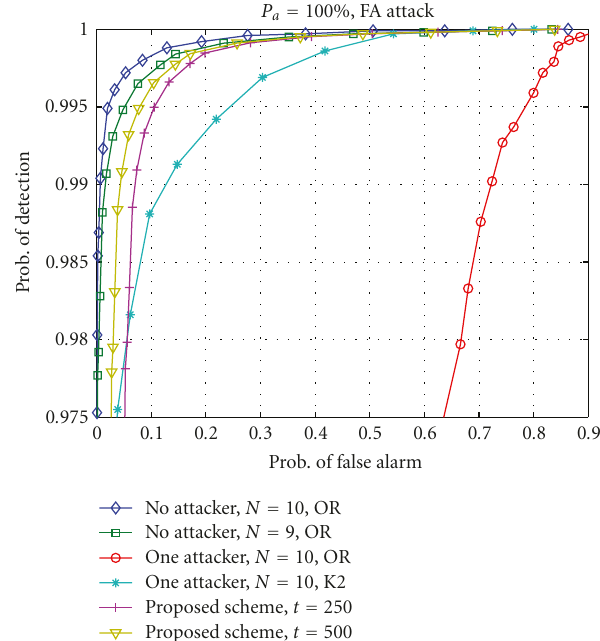
Figure 2: ROC curves for di ff erent collaborative sensing schemes ( P a = 100%, False Alarm